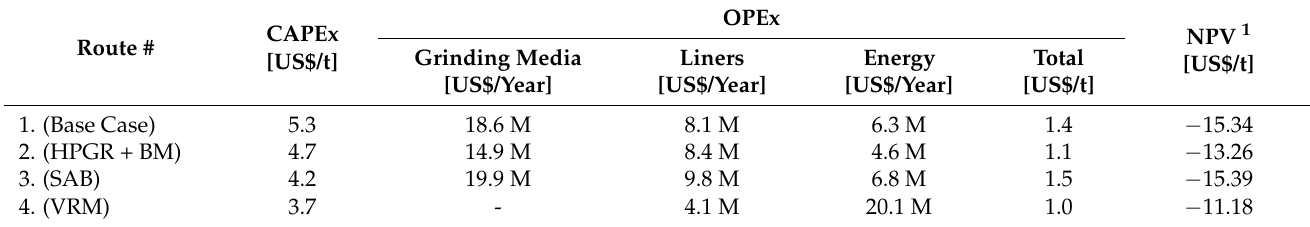
Table 3. Main costs estimated for each processing